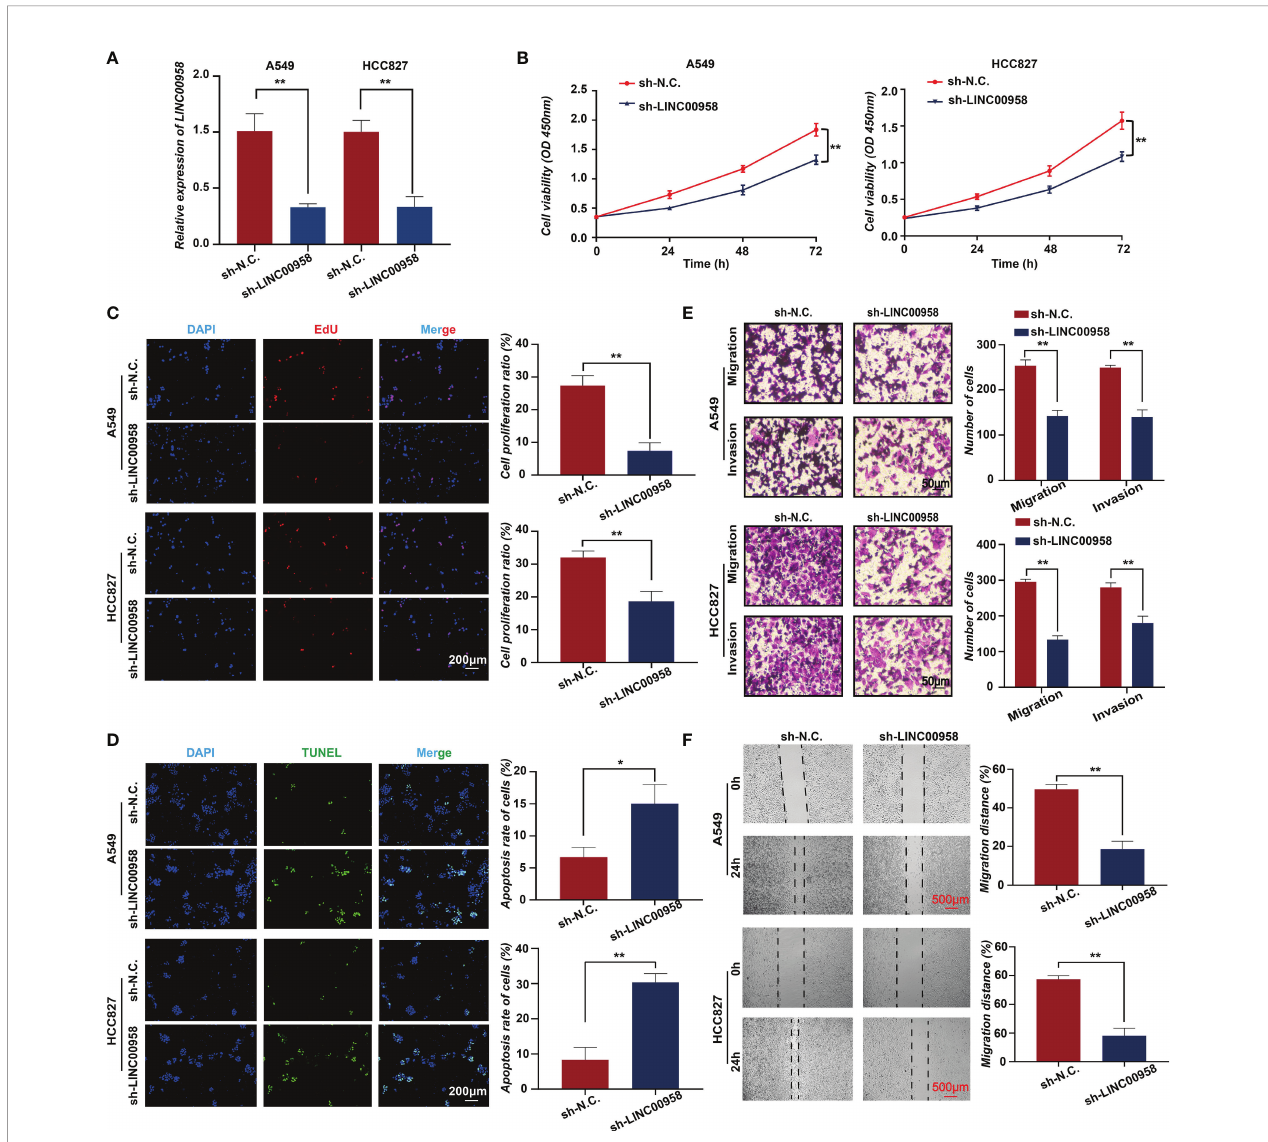
FIGURE 2 | In vitro functions of LINC00958 in lung adenocarcinoma (LUAD). (A) The silencing ef fi cacy of short hairpin RNA (shRNA) targeting LINC00958 in A549 and HCC827 cells. (B) Tumor cell growth was examined using the cell counting kit-8 assays at 0, 24, 48, and 72 h. (C) The effect of LINC00958 knockdown on cell proliferation was examined using the 5-ethynyl-2 ′ -deoxyuridine assay. (D) Terminal deoxynucleotidyl transferase biotin-dUTP nick end labeling assay was performed to examine the effect of LINC00958 knockdown on cell apoptosis. (E) Transwell assay was performed to examine the effect of LINC00958 knockdown on the migration of LUAD cells. (F) Wound-healing assay was performed to examine the migration rate of LINC00958 knockdown and control LUAD cells. All assays were repeated three times. * P < 0.05, ** P <